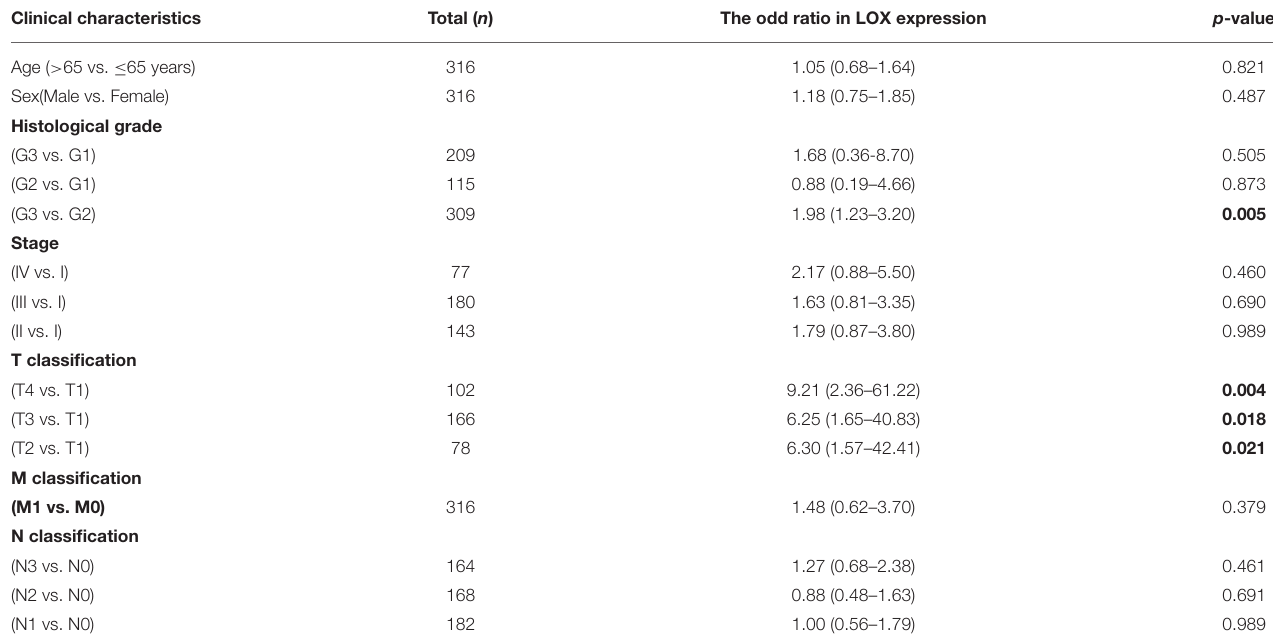
TABLE 2 | LOX expression associated with clinical characteristics (logistic